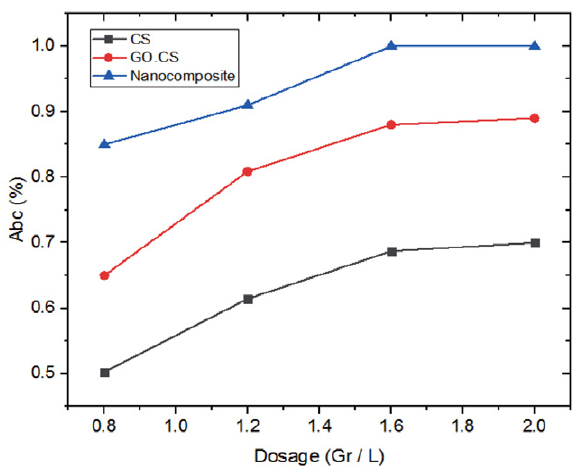
Figure 7. The effect of the used CS, GO-CS, fabricated nanocom- posite adsorbent on the DOX